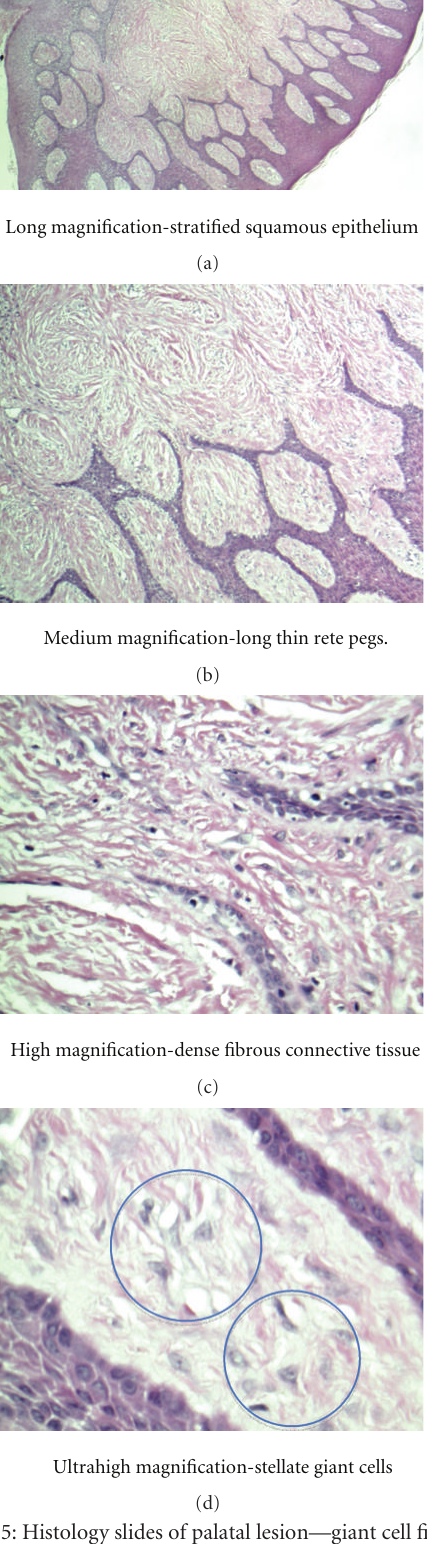
Figure 5: Histology slides of palatal lesion—giant cell